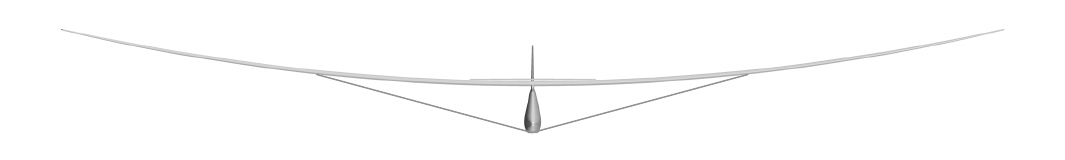
Figure 11. Lift wires of the